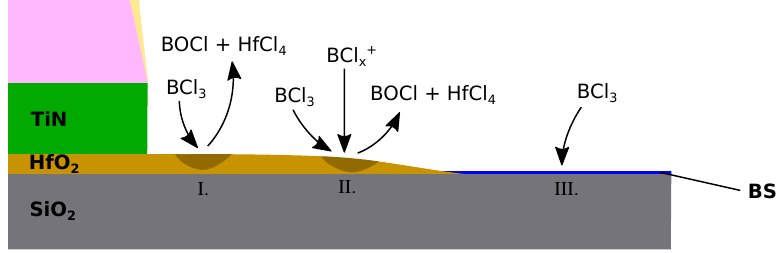
Figure 16. Etch mechanisms leading to infinite etch selectivity of HfO 2 over SiO 2 through I. chemical and II. ion-enhanced etching of HfO 2 , with III. additional chemical deposition of BSi on the SiO 2